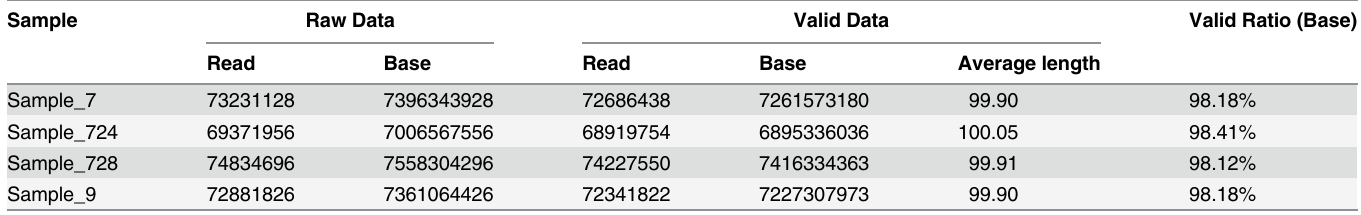
Table 1. Reads before and after quality control and data